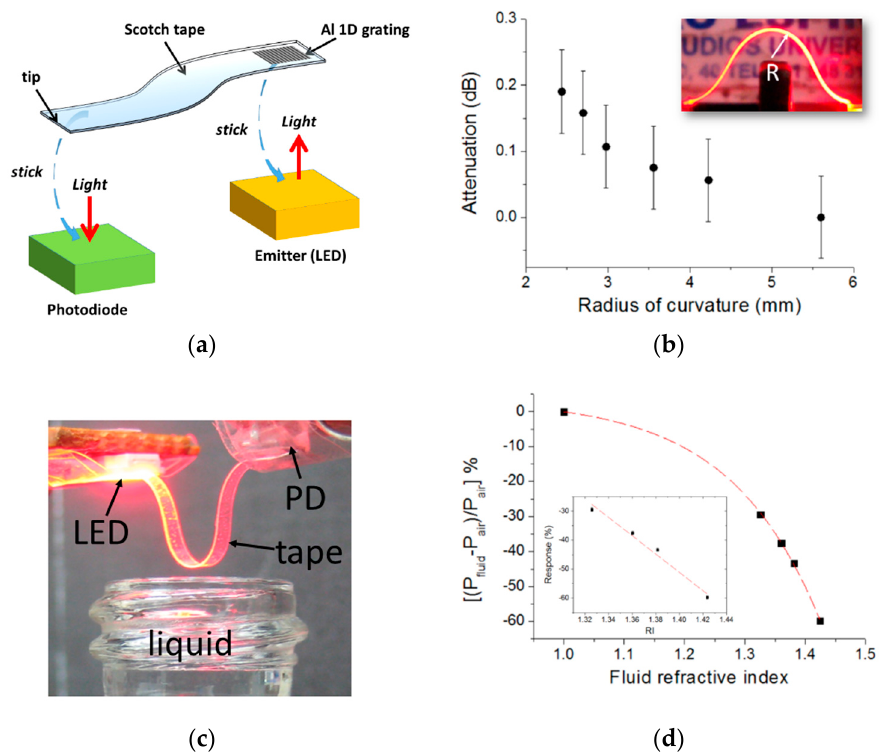
Figure 4. ( a ) Schematics of the assembly of a liquid refractive index optical sensor based on a Scotch tape waveguide with an integrated aluminum one-dimensional (1D) grating coupler. ( b ) Bending attenuation of a 24.7-mm-long tape waveguide at different radii of curvature (R). ( c ) U-shaped tape waveguide ready to be immersed in a liquid sample to measure its refractive index. ( d ) Calibration curve of the tape refractive index sensor. Inset shows the measured values in the refractive index range 1.326–1.424. Reprinted from [27].